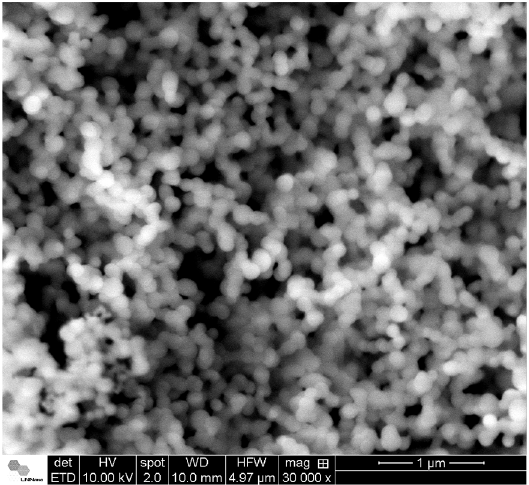
Figure 6. SEM image obtained for soot particles.